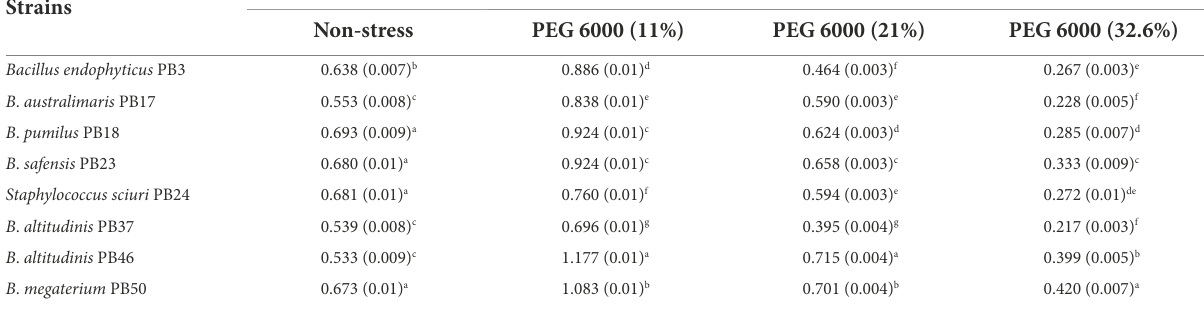
TABLE 3 Mean and standard deviation values of growth of each rice phyllosphere bacterial strain (number of replicates, n = 3) measured under three different osmotic stress conditions and a non-stress